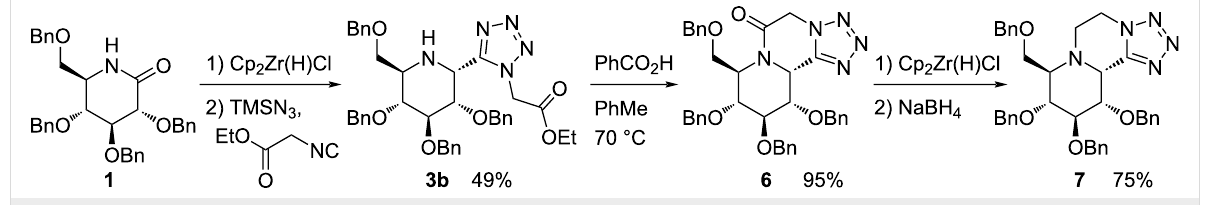
Scheme 3: Synthesis of a new class of alkaloid sca ff old using the presented methodology.